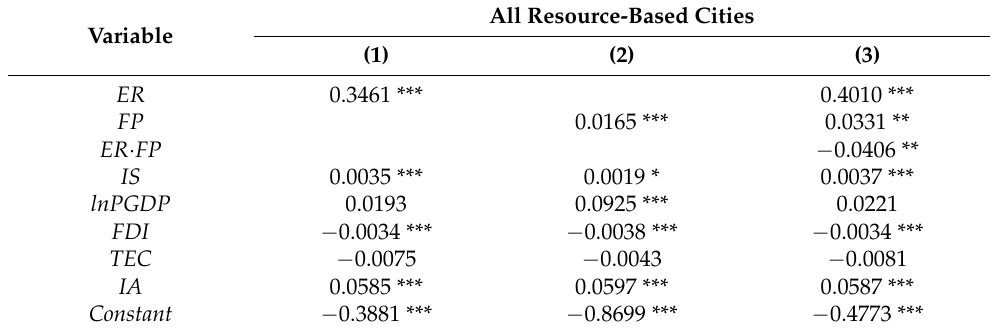
Table 3. Regression results for all